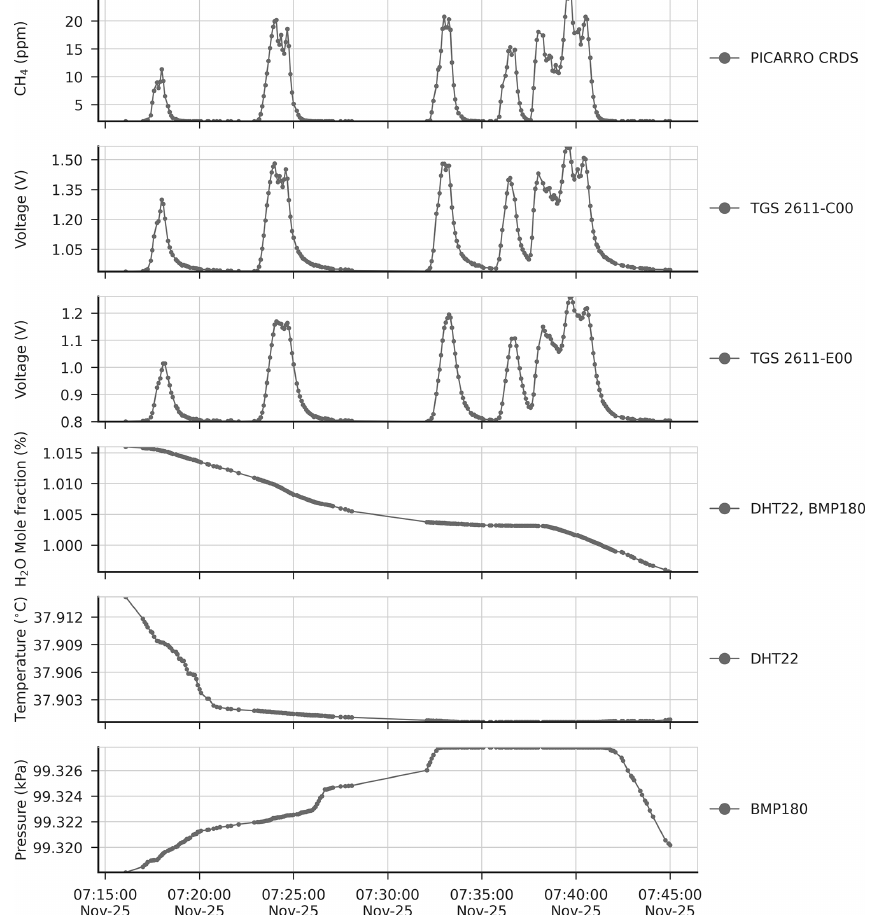
Figure 3. Top to bottom: time series of reference CH 4 signal from CRDS, voltage from TGS sensors, H 2 O, temperature and pressure during a period of 30min, after removing the variations of background signals from the time series and applying the H 2 O correction to the voltage signal of TGS sensors. Dots in panels represent actual observations, and lines between dots are drawn to show the shape of the